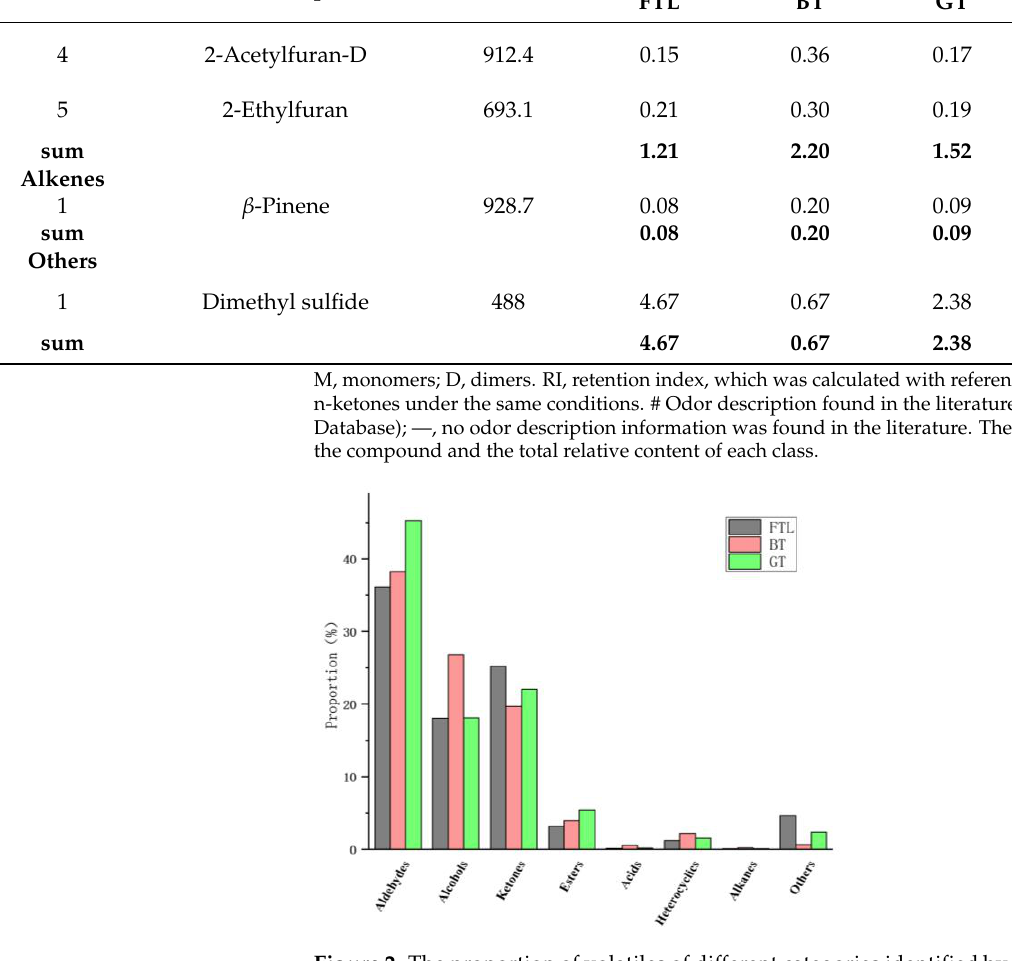
Figure 2. The proportion of volatiles of different categories identified by GC – IMS in three tea samples.